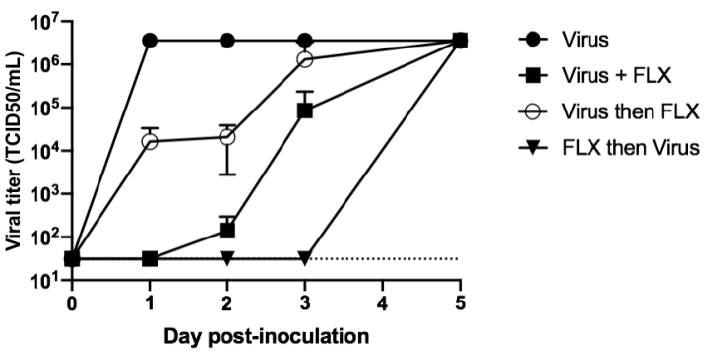
Figure 2. Levels of infectious particles in cell cultures treated with fluoxetine (FLX) before, during, or after inoculation of SARS-CoV-2. Vero E6 cells were seeded in 24-well plates at 10 5 cells per well. The cells were inoculated with SARS-CoV-2 (black circles), SARS-CoV-2 + 10 µ M of FLX (black squares), or SARS-CoV-2 incubated for 2 h and then treated with 10 µ M of FLX (white circles), or the cells were incubated for 2 h in presence of 10 µ M of FLX, followed by inoculation with SARS-CoV-2 and incubation for 2 h (black triangles). For each condition, the MOI was 0.01 and the cells were washed three times with complete medium after incubation and then treated again with 10 µ M of FLX, followed by re-incubation. Levels of infectious particles in supernatants were determined using the endpoint dilution assay at days 1, 2, 3, 5 post-infection. The Spearman–Karber method was used to determine the tissue culture 50% infectious dose (TCID 50 /mL). The results are presented as the mean ± SD of three independent experiments.